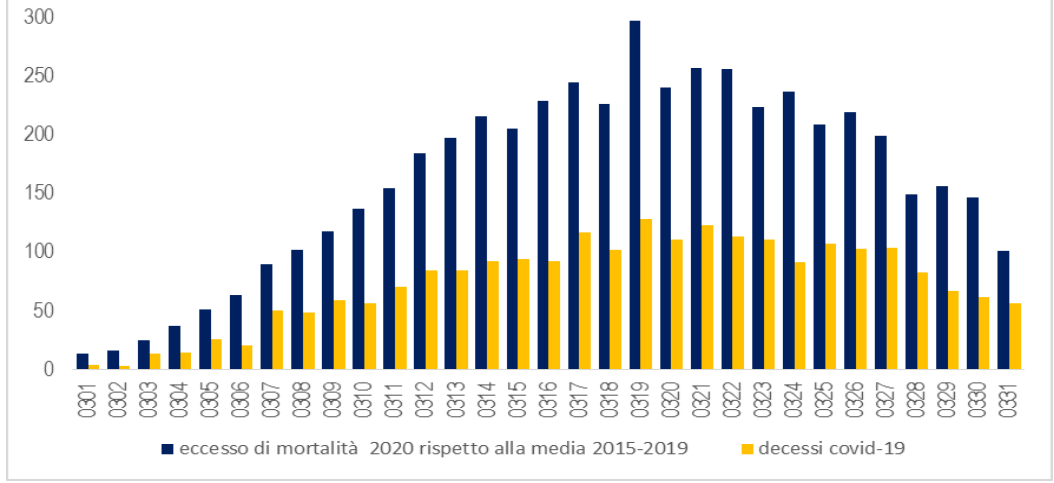
Figura 10. Andamento giornaliero nel mese di marzo dell'eccesso di mortalità registrato nel 2020 rispetto alla media degli anni 2015-2019 e dei decessi Covid- 19 (a) . Valori assoluti dei decessi di persone in età 50 anni e più. Provincia di Bergamo